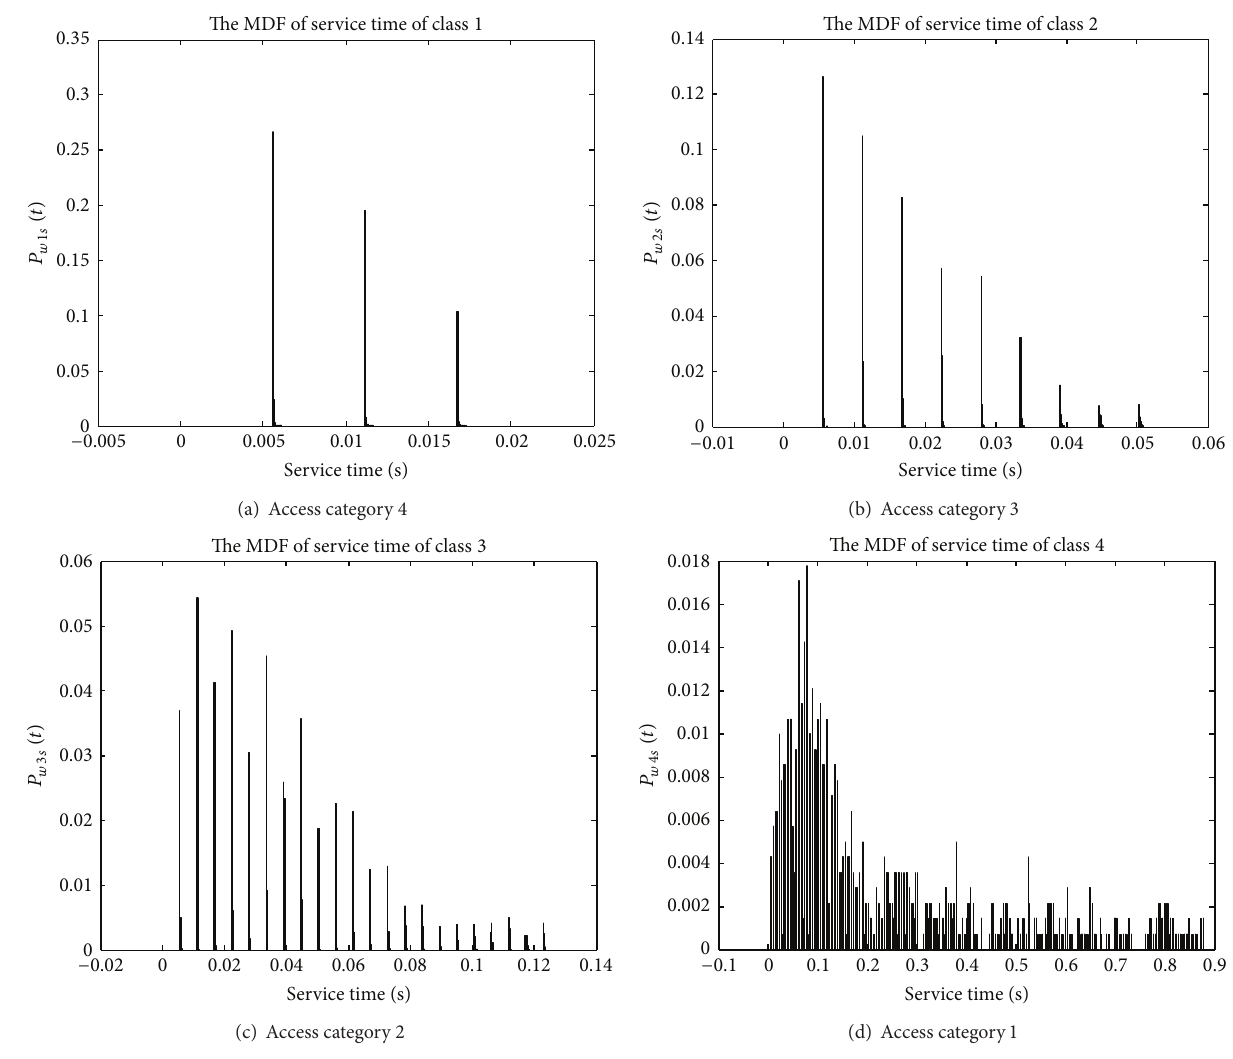
Figure 4: Probability mass